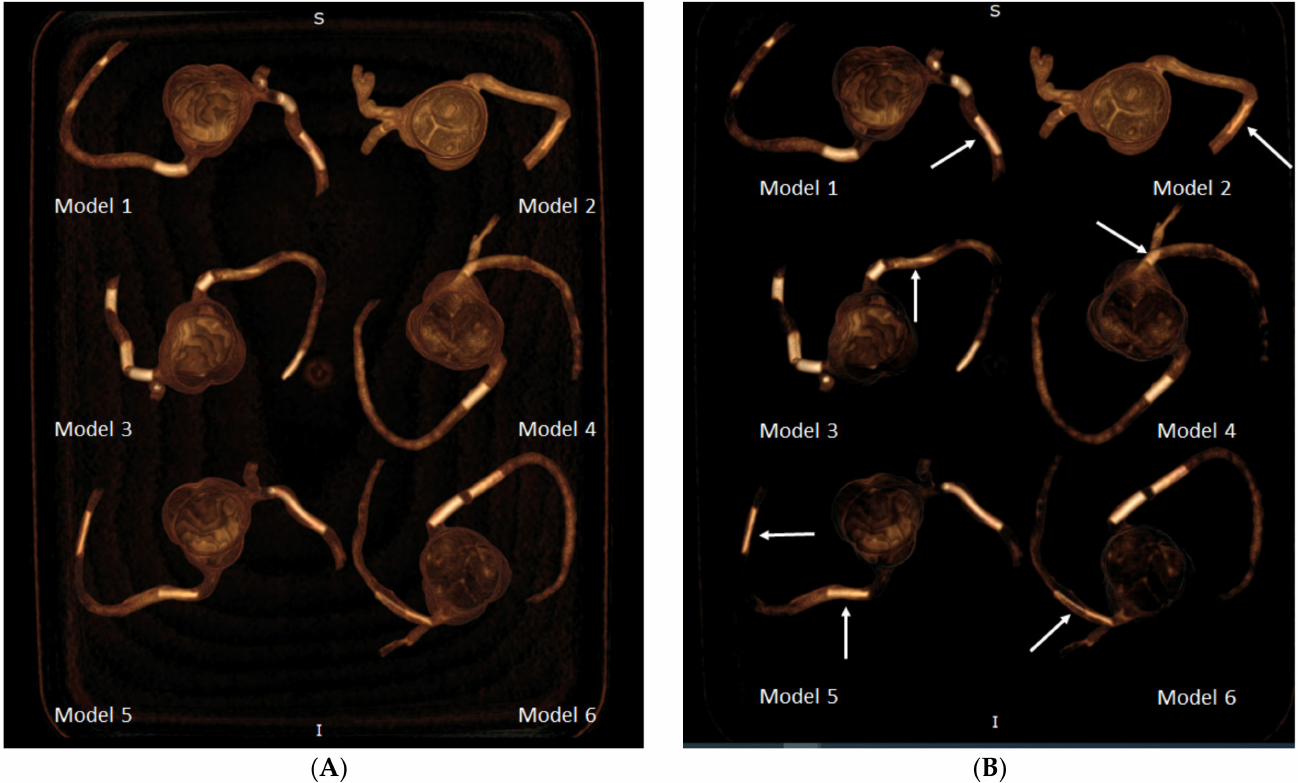
Figure 9. 3D volume rendering (VR) views showing calcified plaques in the coronary arteries. ( A ) VR views with wide window width (window width and window level: 1250 and 250) showing both plaques and coronary lumen in these 3D-printed models. ( B ) When narrow window width (window width and window level: 1050 and 210) is applied, high attenuation plaques are visualised more clearly, with some of the coronary lumen not displayed. This is especially apparent when visualising model 1 (plaque 2), model 2 (plaque 7), model 3 (plaque 13), model 4 (plaque 15), model 5 (plaques 18 and 19), and model 6 (plaque 20). Arrows refer to these plaques better visualised on VR images with narrow window